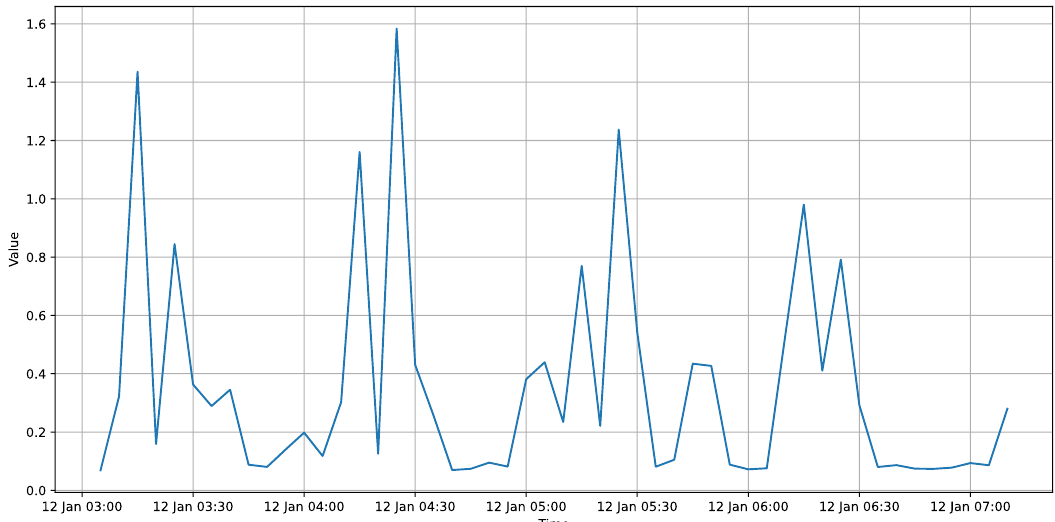
Figure 1. Sample from the collected CPU usage